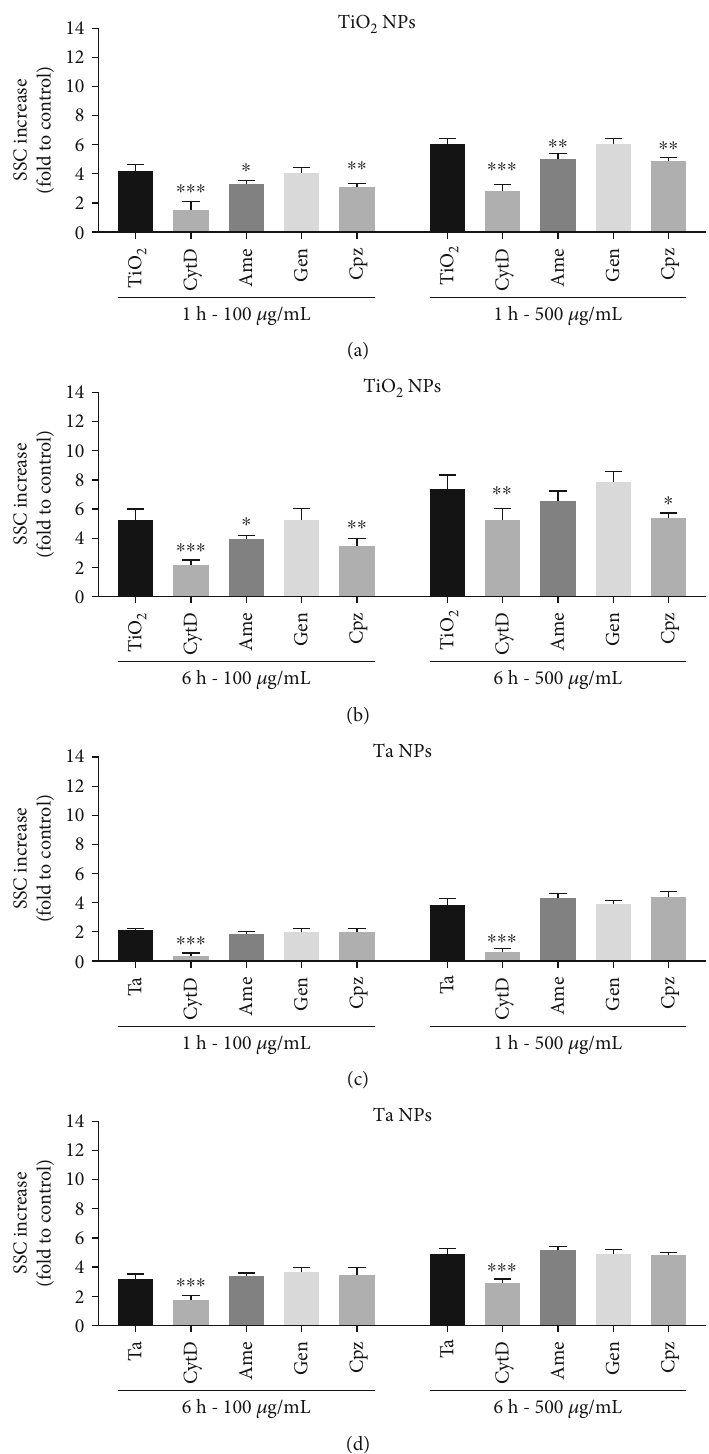
Figure 4: TiO and Ta NP internalization and their particle-speci fi c uptake routes. THP-1-derived macrophages were pretreated with 2 di ff erent uptake inhibitors for 30min and then exposed to (a) TiO and (b) Ta NPs at 100 and 500 μ g/mL for 1 and 6h. Changes in side 2 scatter (SSC) were analyzed with fl ow cytometry. SSC changes at 4 ° C were subtracted, and data were expressed as mean + SD as fold of NP-untreated cells (Nc) of three independent experiments. Statistical di ff erences were shown as ∗ p < 0 : 05 , ∗∗ p < 0 : 01 , and ∗∗∗ p < 0 : 001 for inhibitor-treated groups vs. cells treated with particles